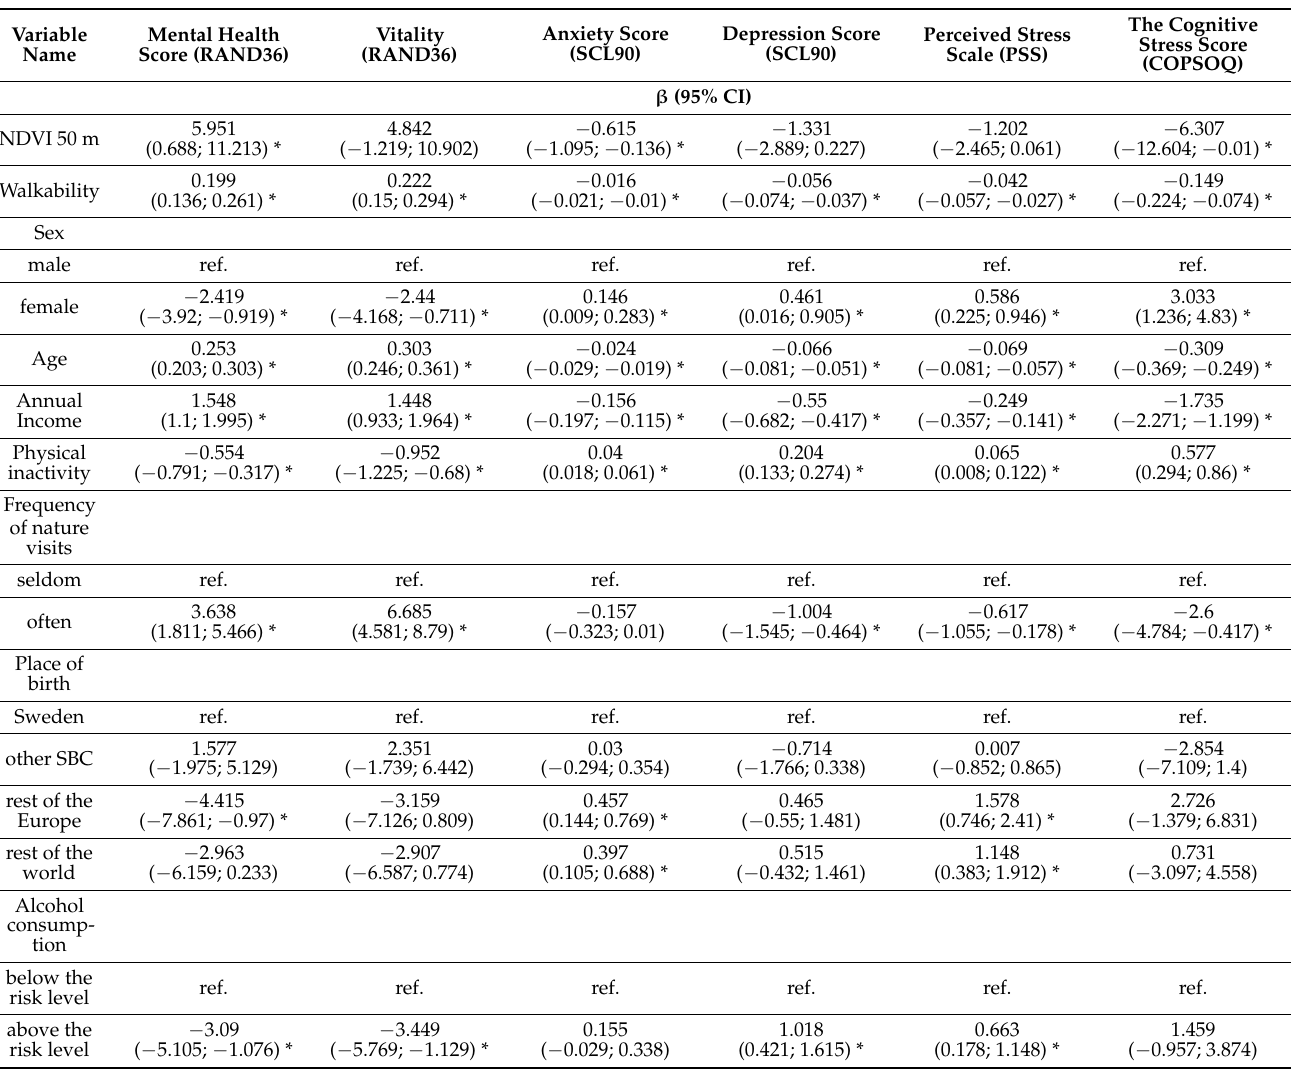
Table 8. Association between NDVI within 50 m and the mental health estimates—fully adjusted model (* p < 0.05; CI—confidence